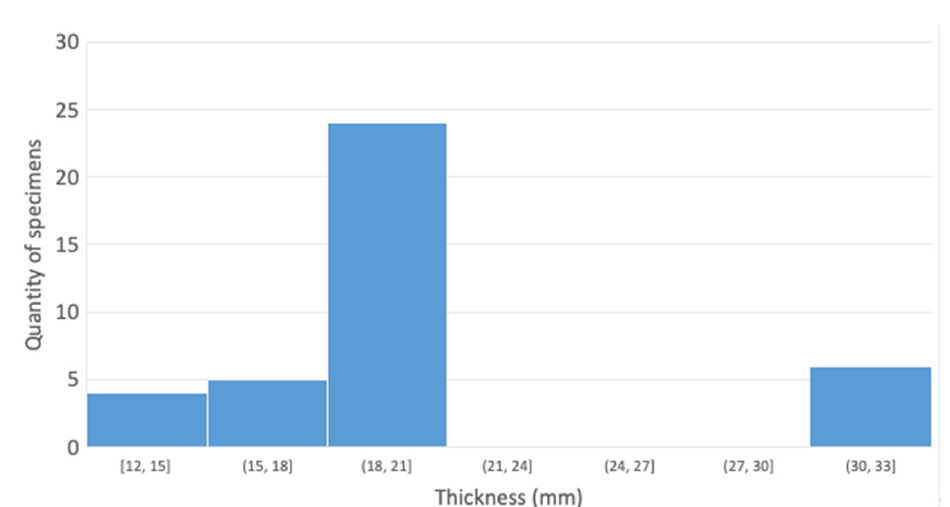
J. Mar. Sci. Eng. 2020 , 8 , x Response to PEER REVIEW Figure 23. Histogram of thickness with FC tubular joint samples. Figure 21. Histogram of thickness with FC tubular joint samples.